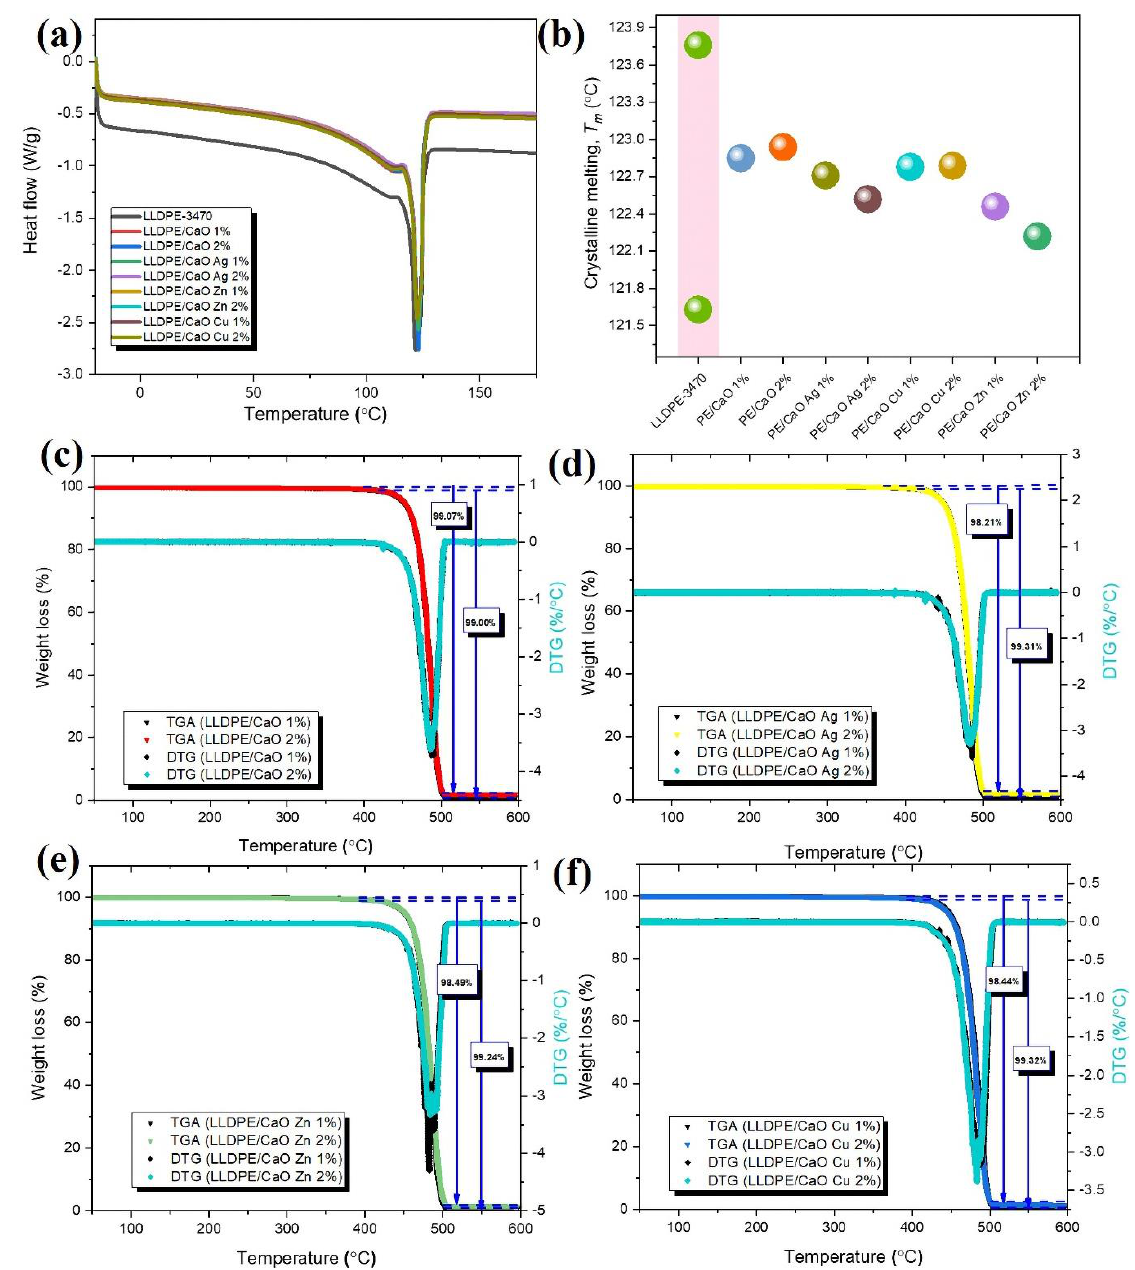
Figure 6. ( a ) DSC curves in the glass transition region of LLDPE/CaO, LLDPE/CaO Ag, LLDPE/CaO Zn, and LLDPE/CaO Cu against filler content (wt%), ( b ) T m values. Thermogravimetric analysis (TGA, DTG) traces of ( c ) LLDPE/CaO, ( d ) LLDPE/CaO Ag, ( e ) LLDPE/CaO Zn, and ( f ) LLDPE/CaO Cu against filler content (wt%).